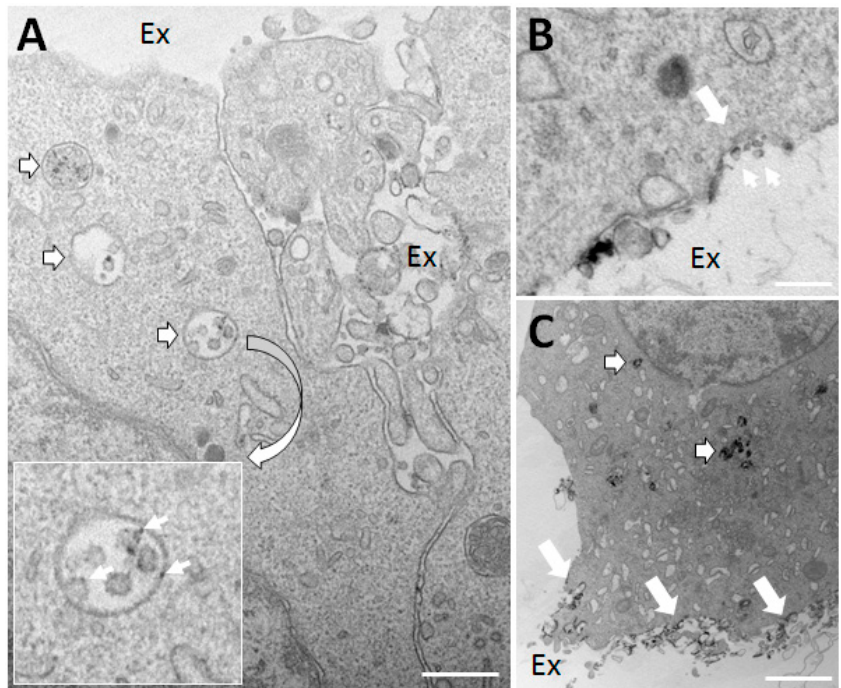
Figure 3. PC12 nerve cells in the process of differentiation secrete exosomes with oxidant production capacity. ( A , B ) PC12 neuron-like cells under differentiation induced by nerve growth factor (NGF) for four days were treated with phorbol myristate acetate (PMA) for one hour (to activate NADPH oxidase) in the presence of cerium chloride (CeCl 3 ), a cytochemical agent, which forms an electron- dense precipitate upon reaction with hydrogen peroxide. ( A ) Note the presence of multivesicular bodies/late endosomes (outlined white arrows) containing intraluminal vesicles (exosomes to be) with clear deposition of CeCl 3 (see inset) indicative of hydrogen peroxide production. Ex, extracellular space. ( B ) A profile suggesting the exocytosis of a late endosome (large white arrow) leading to the release of exosomes with hydrogen peroxide production (small arrows). ( C ) In addition to activating NOX2, PMA is a strong secretagogue. After three hours of PMA stimulation a countable number of late endosomes are clearly stained with CeCl 3 precipitates (outlined white arrows), and substantial amounts of material with precipitate is seen deposited on the cell surface following their exocytosis (large white arrows). Bars, 250 nm in ( A , B ); 2 µ m in ( C